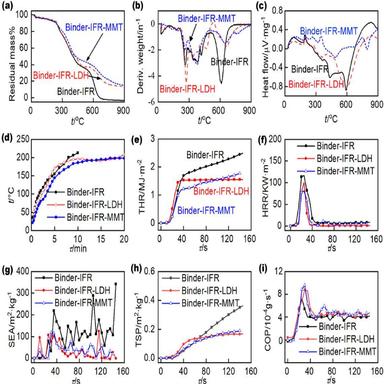
Test parameters for various types of coatings. (a) TG, (b) DTG, and (c) DTA curves of the temperature programmed oxidation experiments. (d) Temperature profiles of the test samples during the fire test. (e) THR, (f) HRR, (g) SEA, (h) TSP, and (i) COP of the cone combustion test. (A colour version of this figure can be viewed online.)